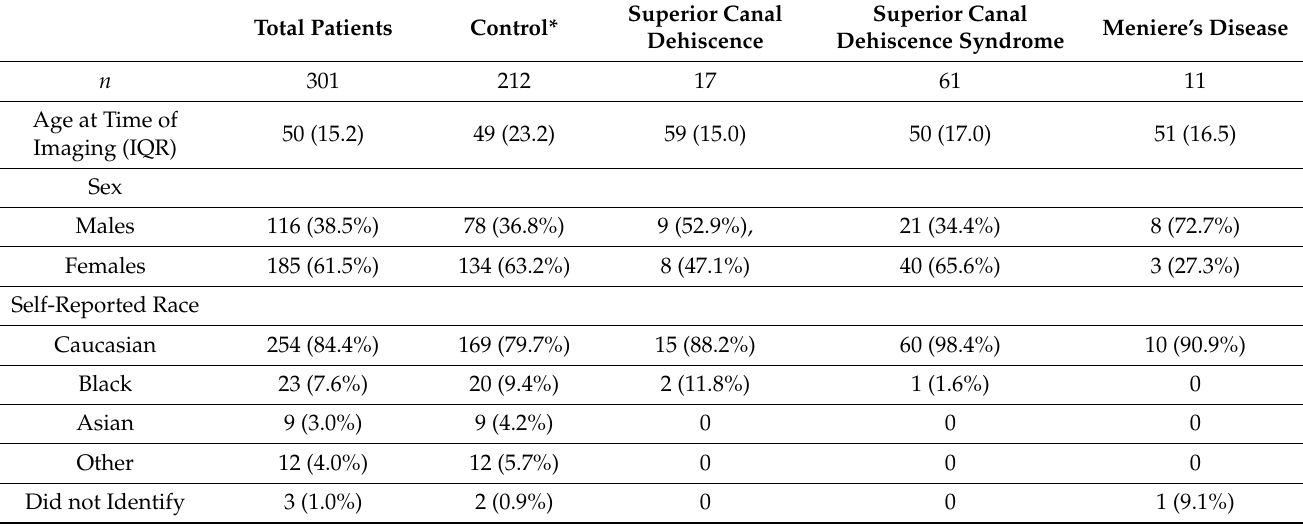
Table 1. Baseline